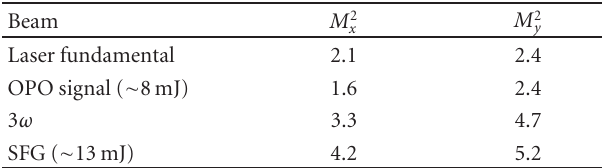
Table 1: Calculated ( M 2 x , M 2 y ) values (dimensionless) based on measured images of near and far